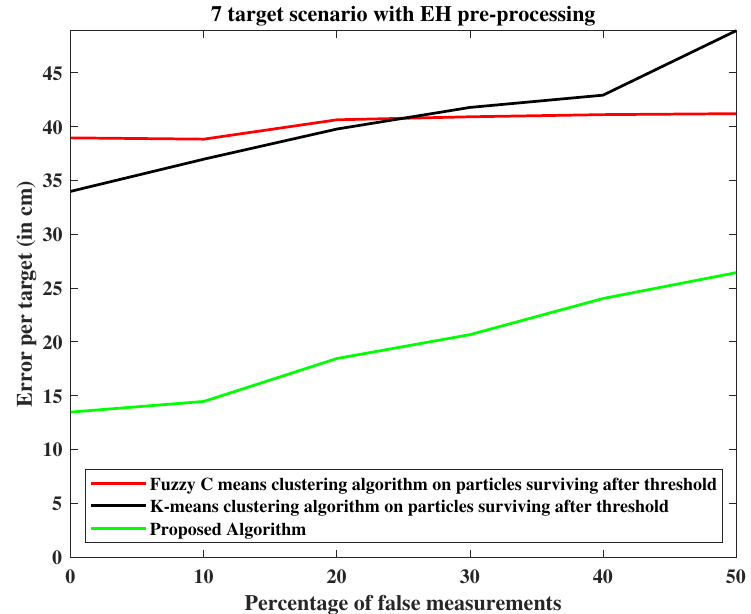
Figure 10. Performance comparison with false measurements and for σ = 0.1 and 25% of missing measurements.